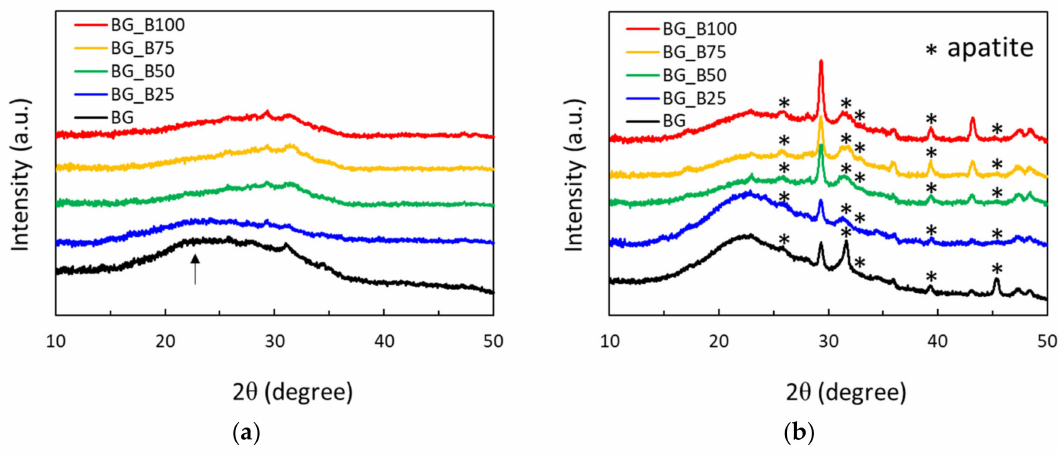
Figure 2. X-ray di ff raction spectra of BG and B-doped BG soaking in simulated body fluid (SBF) for ( a ) 0 and ( b ) 7 days.